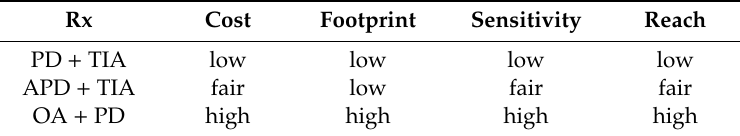
Table 2. Comparison of different receivers [1,7,26,39].